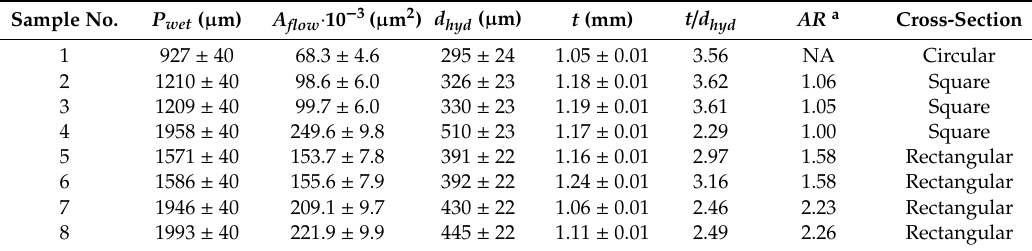
Table 2. Dimensions of the micro-orifice samples.